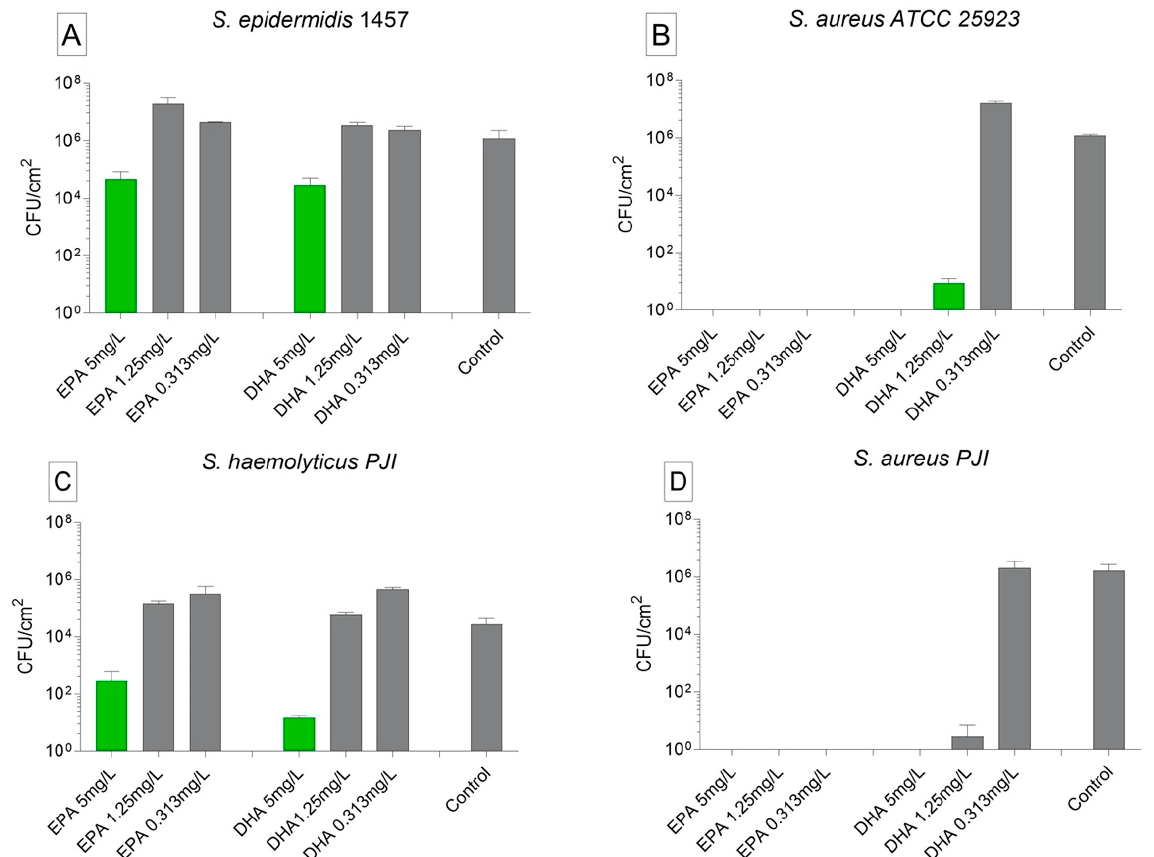
Figure 3. Activity of ω -3 PUFAs for inhibition of biofilm formation—biofilm formation in medium enriched with EPA and DHA, and only with nutrient medium as control. The data are stated as mean ± SEM. ( A ) S. epidermidis 1457; ( B ) S. aureus ATCC 25923; ( C ) S. haemolyticus PJI isolated; ( D ) S. aureus PJI isolated. In green, values significantly different from control group ( p < 0.0001). Statistical analyzed with two-way ANOVA and Turkey’s multiple comparison tests. All the tests were repeated twice and carried out in triplicates.